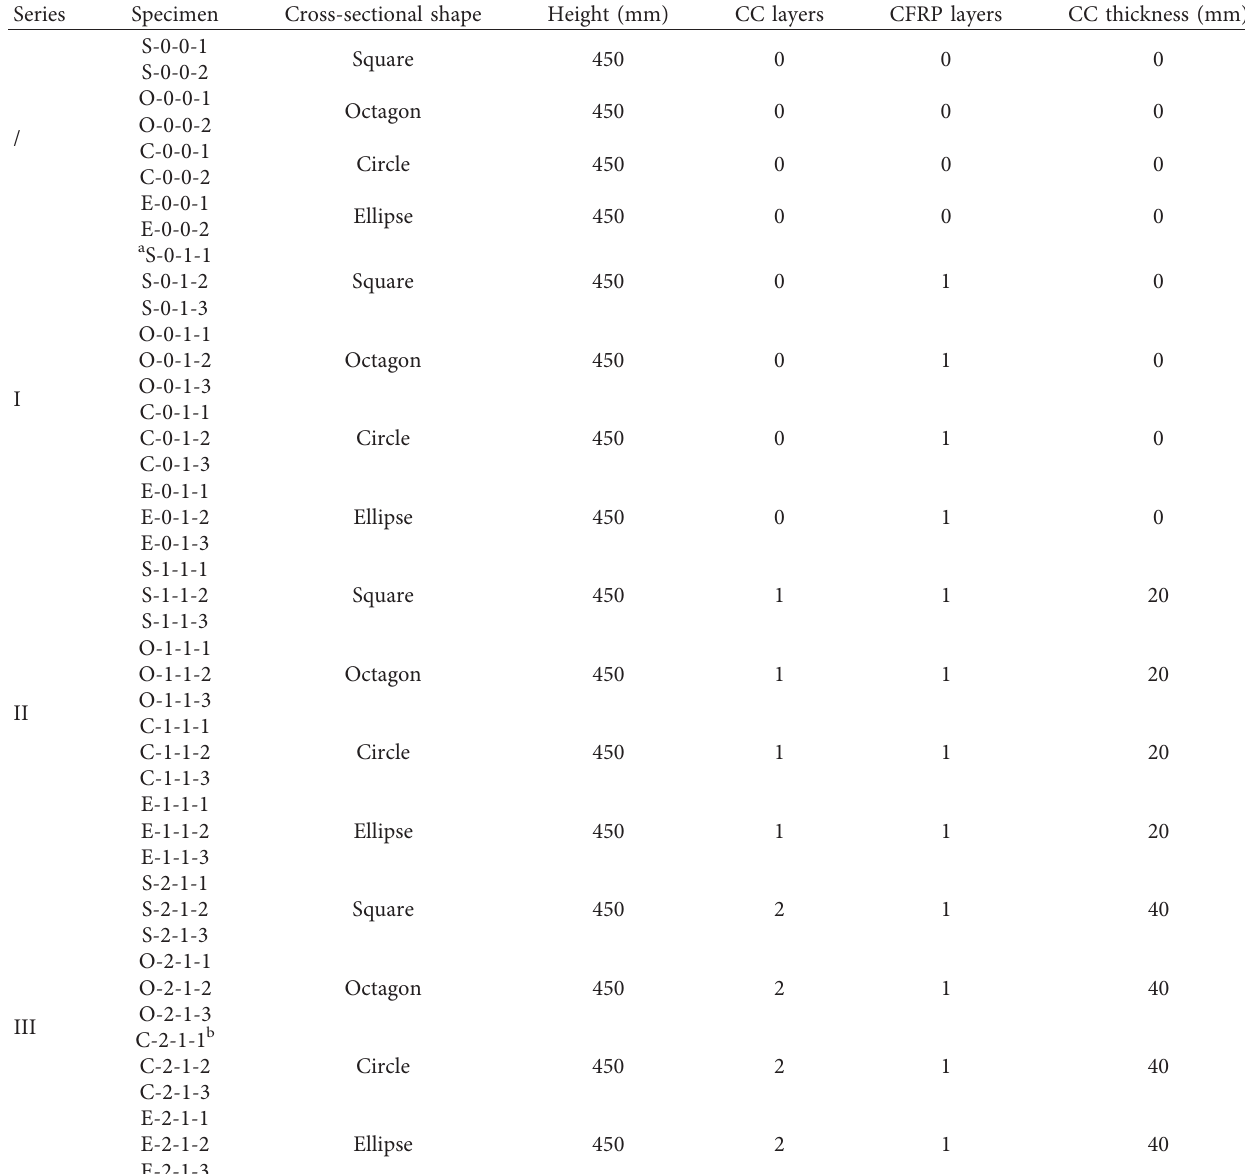
Table 1: Experimental matrix of specimen